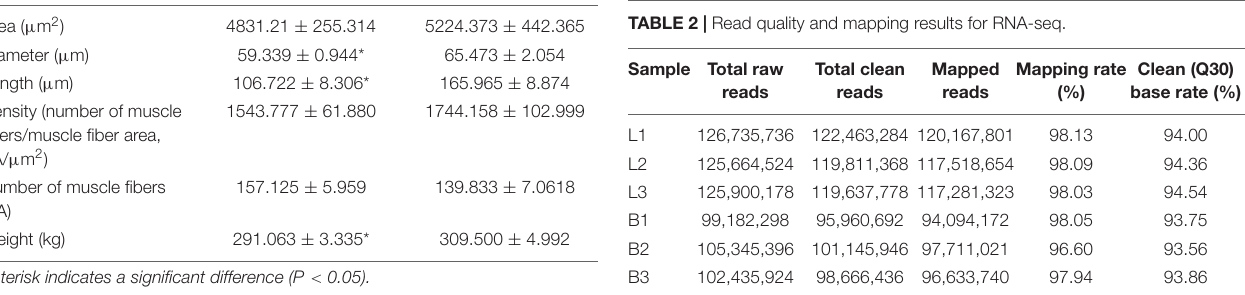
TABLE 1 | Comparison of muscle fiber characteristics and growth characteristics of different breeds of cattle.